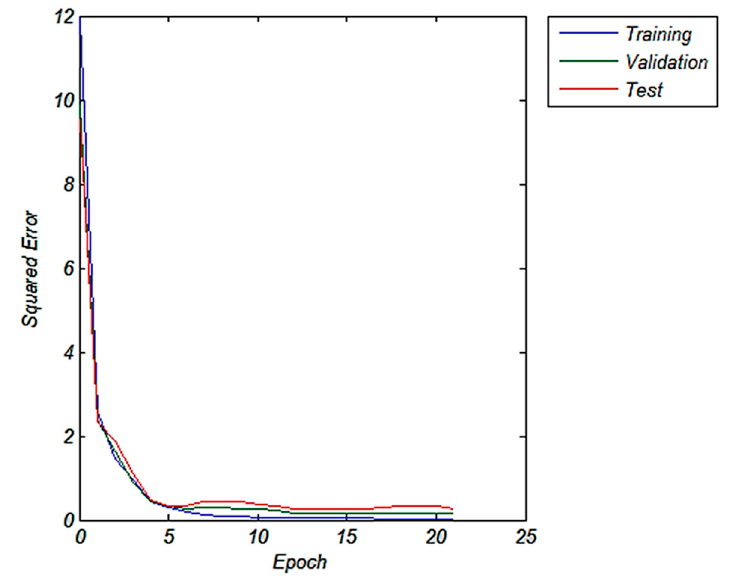
Figure 6. The training, validation, and testing errors versus the number of epochs (iterations).